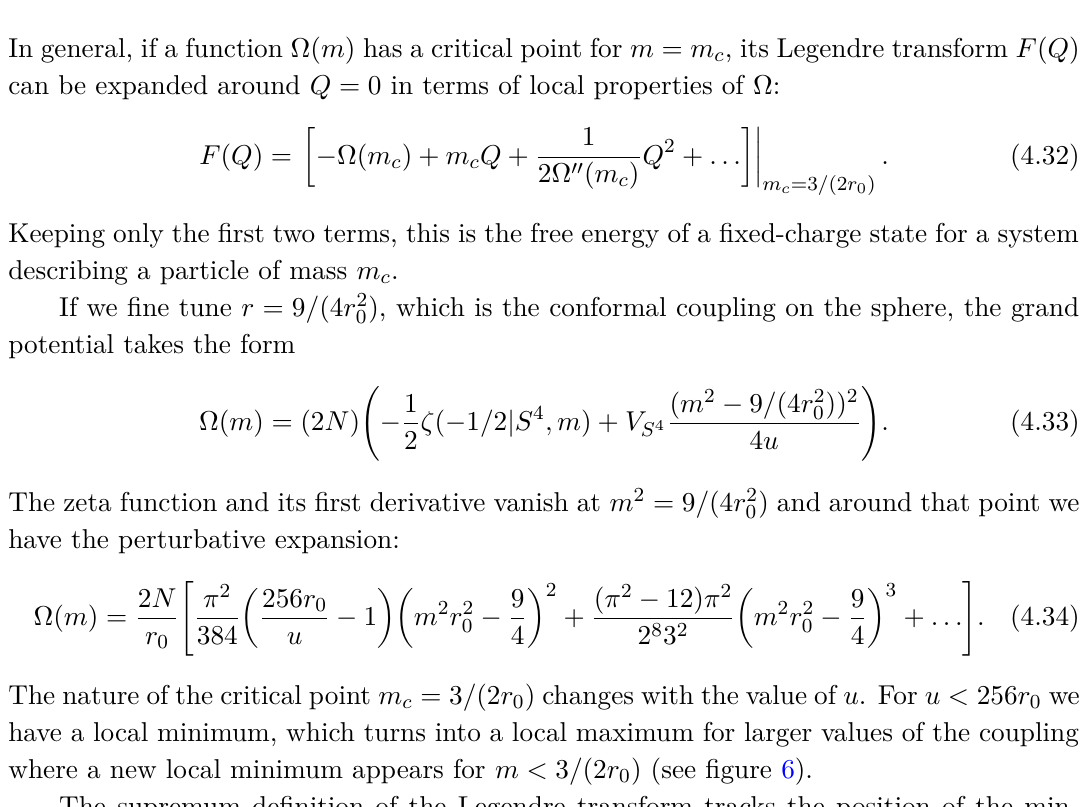
Figure 6 . The grand potential Ω on the cylinder R × S 4 For u < 256 r , the point m = 3 / (2 r ) is a local minimum. For larger values of u a new minimum 0 0 appears for m < 3 / (2 r ) 0